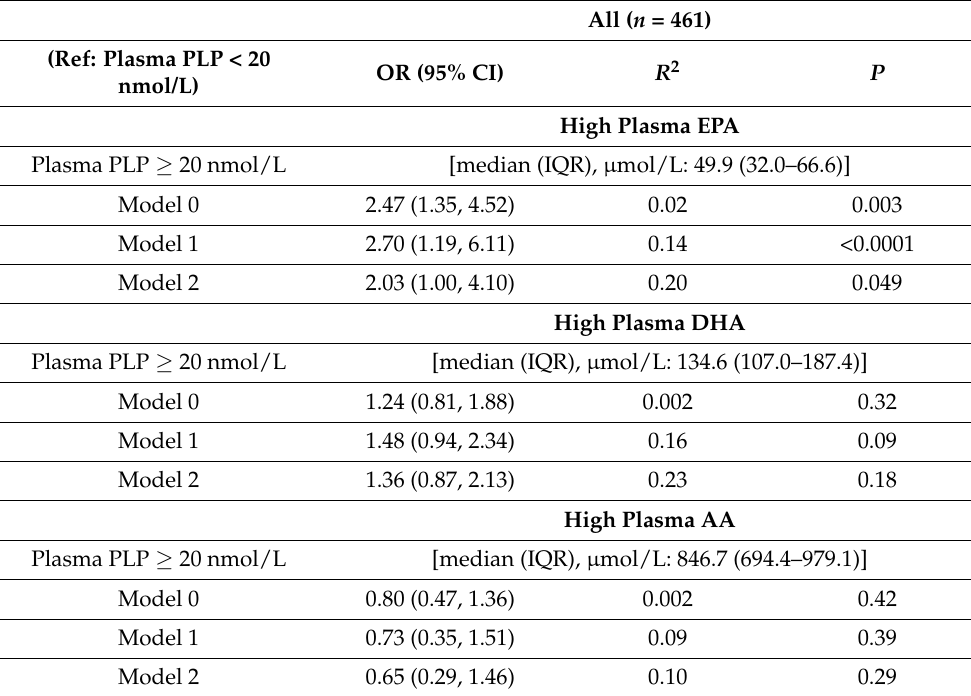
Table 5. Logistic regression models: Odds ratios of high (above median) plasma PUFA status